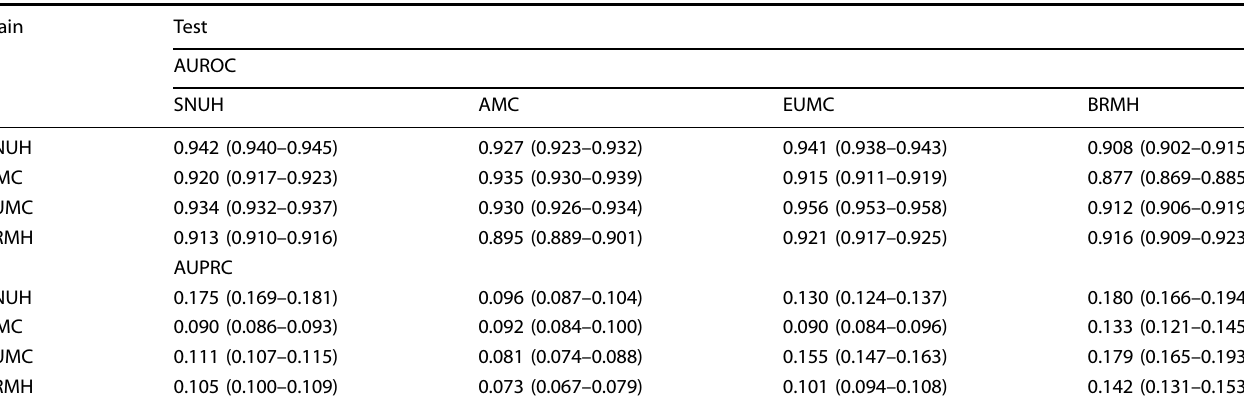
Table 2. Validation results of four models using all features for postoperative 30-day